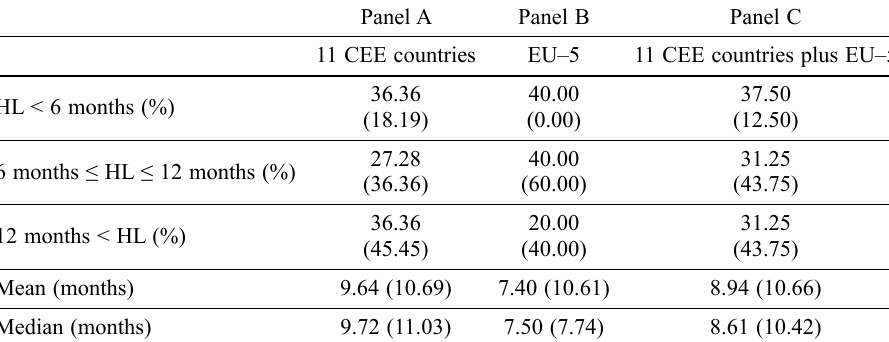
Table 4. Proportion of the upper bound of the half-life Panel A Panel B Panel C 11 CEE countries EU–5 11 CEE countries plus EU–5